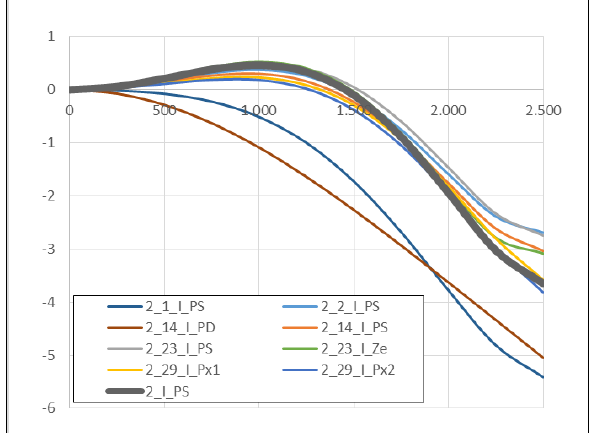
Figure 9. Estimated curves of radial distortion for image sensor.